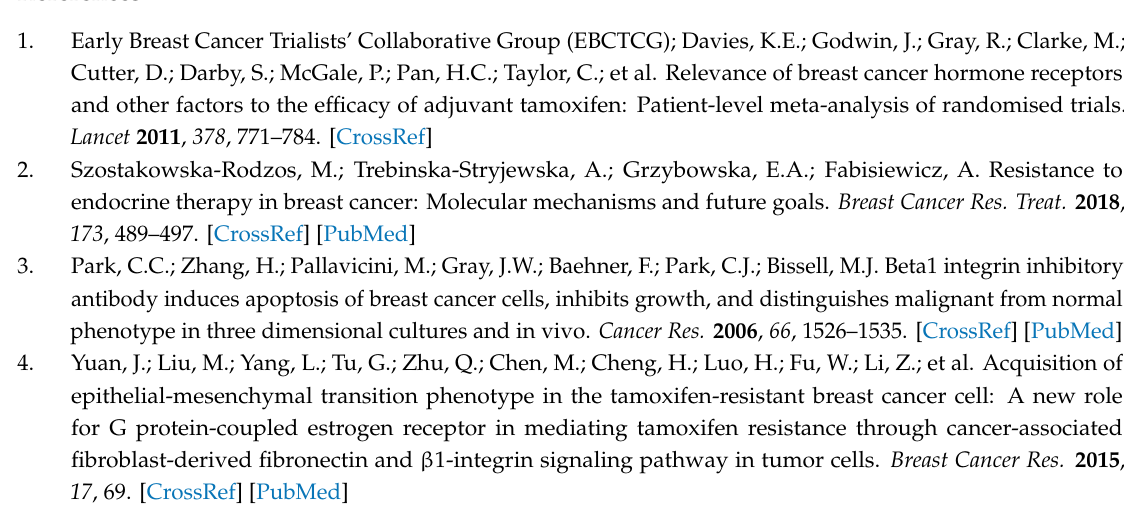
triple negative breast cancer using the following datasets ( A ) METABRIC ( B ) KM-Plotter ( C ) bc-GenExMiner. of DBN1 mRNA expression in patients with luminal breast cancer who received adjuvant endocrine treatment using KM-Plotter dataset, Figure S5: ( A ) Flow diagram illustrating the study design. ( B ) Flow diagram illustrating the filtering stages used to identify DEGs, Figure S6: Western blotting result for DBN1 expression in MCF7 breast cancer cell lysate, Figure S7: Western blotting result for DBN1 expression in MCF7 breast cancer cell lysate, Table S1: Weighted Average Di ff erence (WAD) statistics and ranking of the top DEGs associated with unresponsive cases to endocrine treatment, Table S2: List of pathways associated with the DEGs associated with unresponsive cases to endocrine therapy, Table S3: Association of DBN1 expression and clinicopathological parameters in luminal breast cancer, Table S4: Clinicopathological characteristics of luminal breast cancer